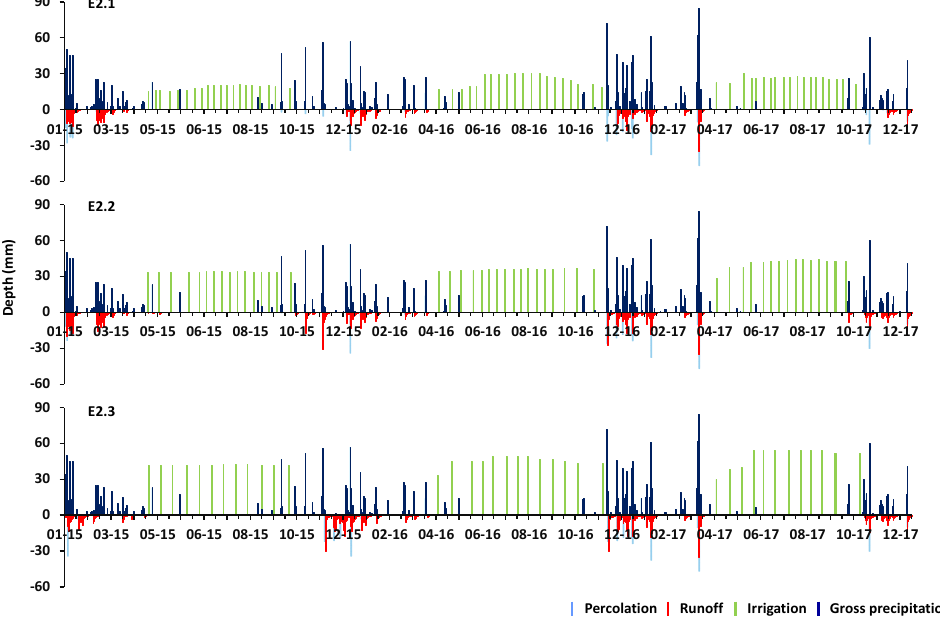
Figure 9. Daily values of percolation and runoff in E2 plots during the 2015–2017 growing seasons.